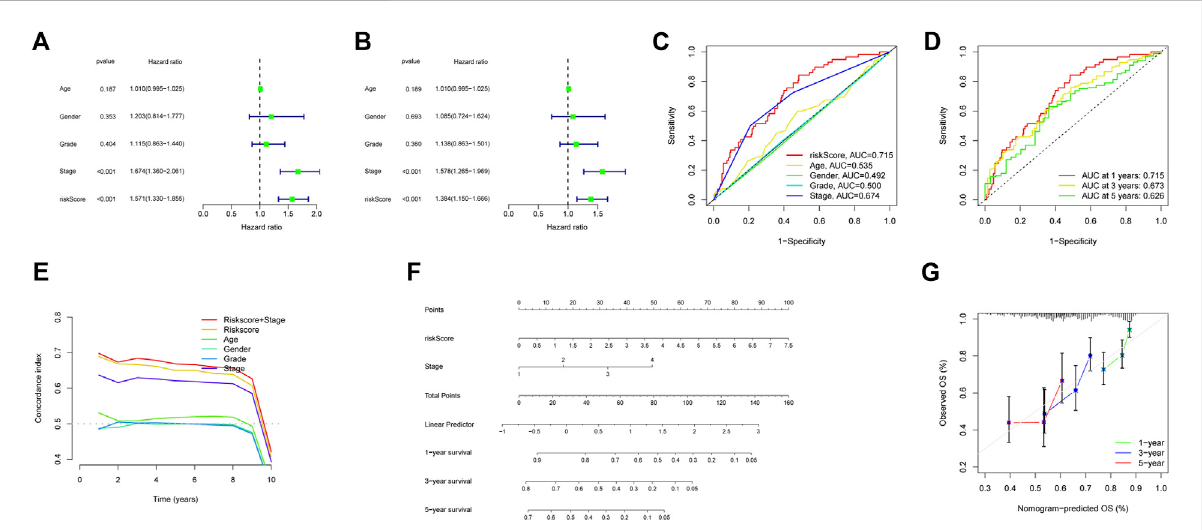
FIGURE 6 Building a Nomogram and Evaluating Its Performance. (A) The AJCC stage and risk score were shown to be associated with overall survival in a univariateCoxregressionanalysis( p < 0.05). (B) MultivariateCoxregressionanalysiscon fi rmedthesigni fi canceofAJCCstageandriskscoreasindependent predictivemarkersofOSinHCCpatients( p < 0.05). (C) AccordingtotheROCcurve,riskscorewasthemostpredictivemetric. (D) TheROCcurvesof1-year, 3-years,and5-yearsriskscore. (E) C-indexofclinicalfactors. (F) UsingriskscoreandAJCCstage,thisnomogramestimateapatient ’ ssurvivalrateatone, three, and 5 years after diagnosis with HCC. (G) Nomogram accuracy was shown by a calibration curve at one, three, and 5